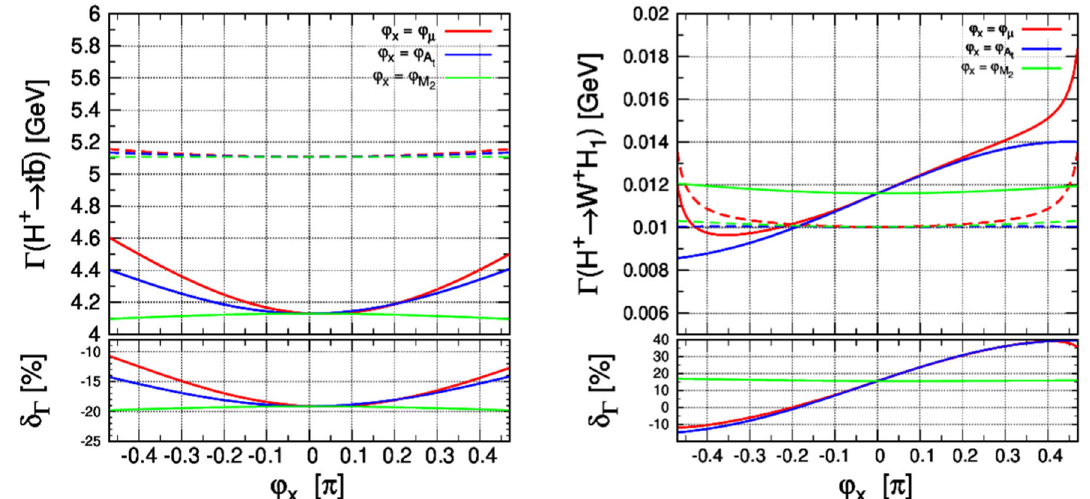
Fig. 7 Left: (cid:20)( H + → t ¯ b ) , right: (cid:20)( H + → W + H 1 ) as function of the CP-violating phase for μ eff (red), A t (blue) and M 2 (green), respectively. Full lines correspond to the decay width at NLO, while dashed lines are those at LO. The lower panels show the relative corrections δ (cid:20) as defined in Eq. (134)